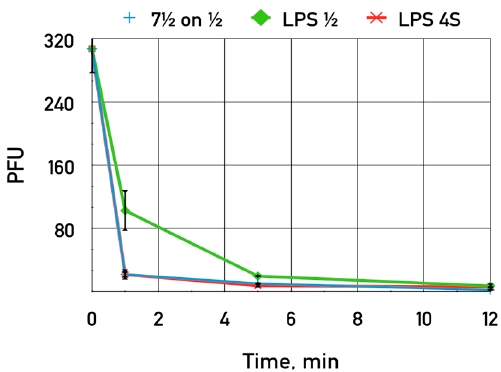
Figure 7. The influence of LPS preparations on the adsorption of bacteriophage DT571/2 on E. coli HS1/2 cells. Blue crosses—control without LPS added, green diamonds—LPS extracted from E. coli HS1/2 added, red stars—LPS from E. coli 4s added. The error bars indicate the SD values.